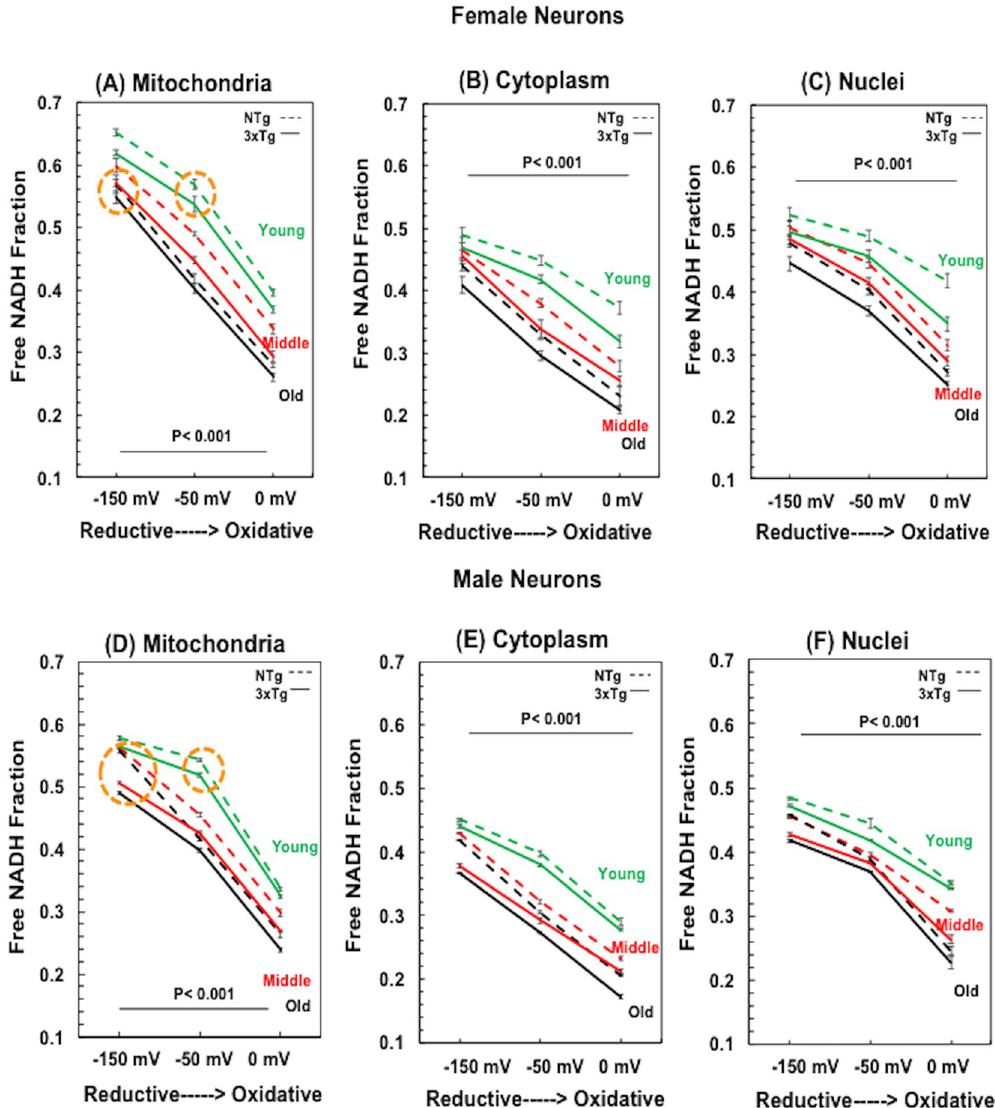
Figure 3. Compartment-specific changes in free NADH fractions with imposed extracellular oxidative (0 mV) and reductive ( − 150 mV) states across ages of NTg and 3xTg-AD mice for both female ( A – C ) and male ( D – F ) neurons. ( A , D ) Mitochondrial free NADH fractions in response to the imposed external Cys/CySS reductive states at − 150 mV and imposed oxidized state at 0 mV in all ages (p < 0.001) of both NTg and 3xTg-AD mice. With external reductive treatment, mitochondrial free NADH fractions can be rescued to the levels of young age at untreated condition (orange circles). Untreated condition of − 50 mV was a control for comparison. At the untreated condition, age effect drove declines in mitochondrial free NADH from young to old age of each genotype (p < 0.001). Moreover, free NADH fractions with genetic load appear to be lower than that of age- and redox- matched NTg neurons (p < 0.001). The imposed oxidative stress depleted free NADH fractions in all ages (p < 0.001). Notably, mitochondrial free NADH fractions in young age always presented highest than the levels of middle and old age in response to the external redox shifts. ( B , E ) Cytoplasmic free NADH fractions and ( C , F ) Nuclear free NADH fractions of female neurons illustrated depletion with oxidative stress (p < 0.001) and elevation in reductive states (p < 0.001) across ages in NTg and 3xTg-AD mice. Similarly, in male neurons. For gender difference, male neurons exhibited lower free NADH fractions than the age-, genotype- and redox- matched female neurons in each compartment, (Mito. F(1, 59) = 13, p < 0.001; Cytoplasm F(1, 59) = 25, p < 0.001; Nuclei F(1, 59) = 13, p < 0.001); This sex-driven redox orders remain unchanged with external oxidized stress, (Mito. F(1, 59) = 33, p < 0.001; Cytoplasm F(1, 59) = 24, p < 0.001; Nuclei F(1, 59) = 5, p = 0.03) and with the imposed reductive state (Mito. F(1, 59) = 22, p < 0.001; Cytoplasm F(1, 59) = 3.7, p = 0.06; Nuclei F(1, 59) = 22, p < 0.001); Genotype effect drove a lower free NADH fraction in 3xTg-AD neurons than the NTg neurons in each age, redox state and compartment (n = 20 female neurons or n = 10 male neurons/ compartment/redox